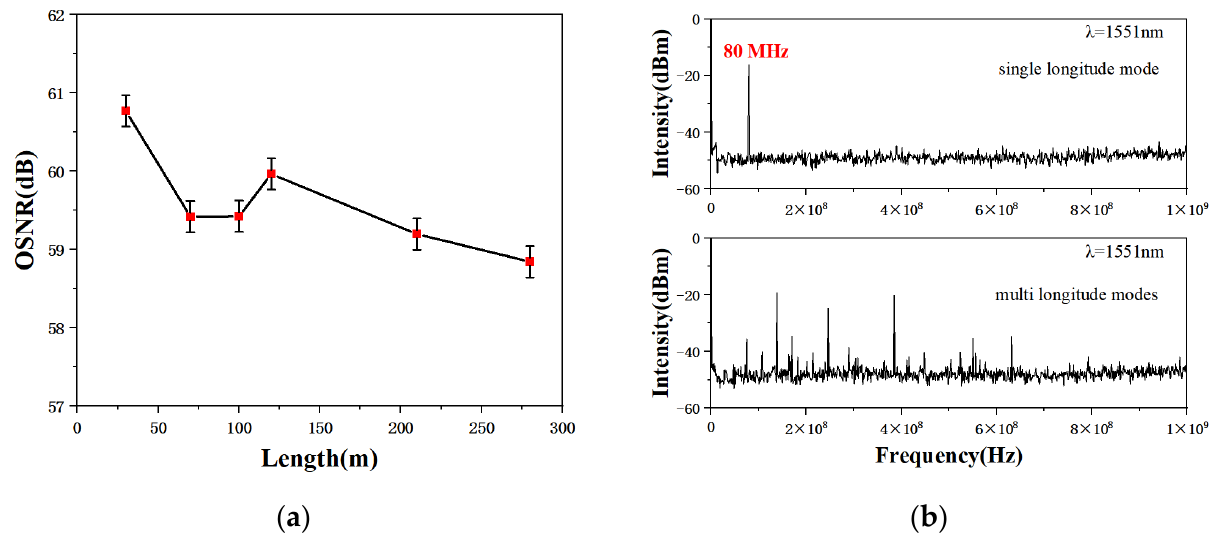
Figure 4. ( a ) OSNR variation with different SMF lengths. ( b ) Electrical spectra of fiber laser show the single longitude mode and multi longitude modes conditions.